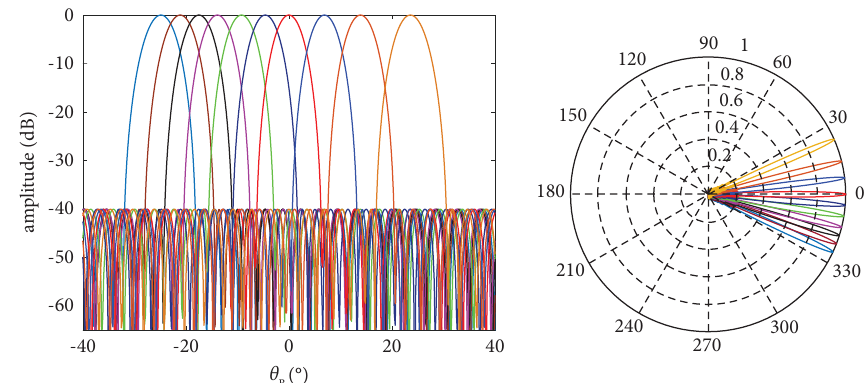
Figure 9: Frequency scanning beamforming system simulation